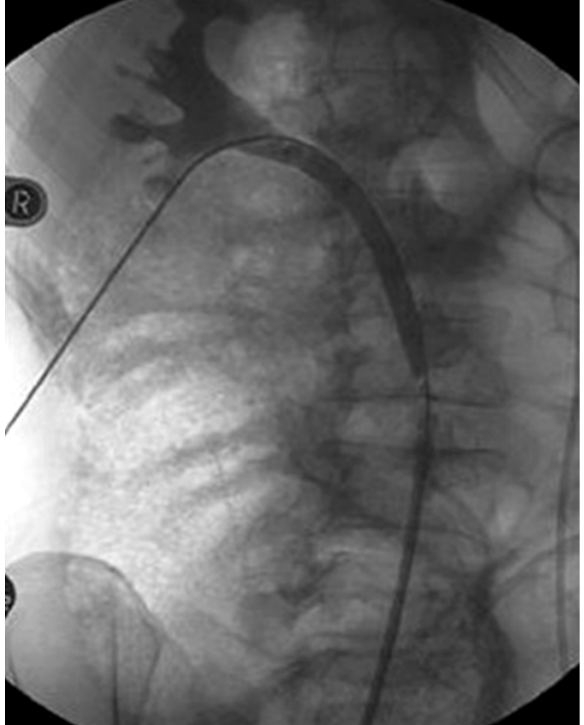
Figure 3 – Placing the floppy guide-wire into the ureter with bent needle through the lower calyx in modified litho- tomy position.